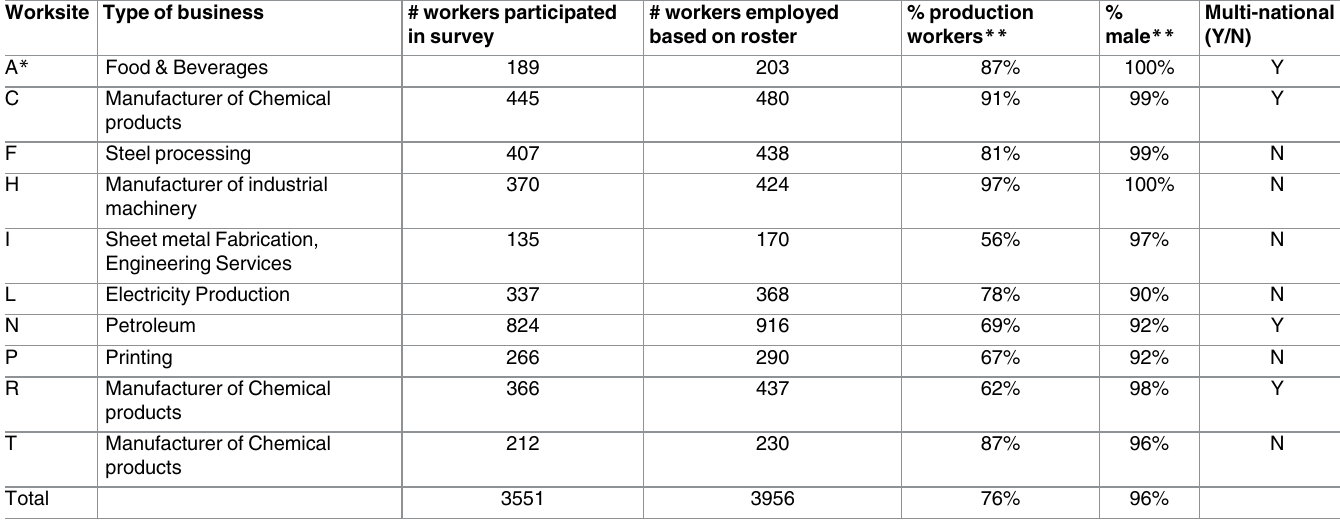
Table 1. Characteristics of the worksites assigned to the intervention condition: Mumbai Worksite Tobacco Control